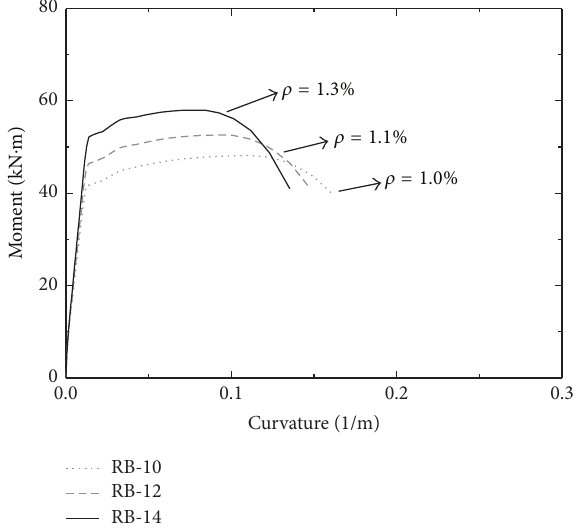
Figure 7: Moment curvature curves of the solid beams. curves of the corresponding entire slotted beam are also given for the purpose of